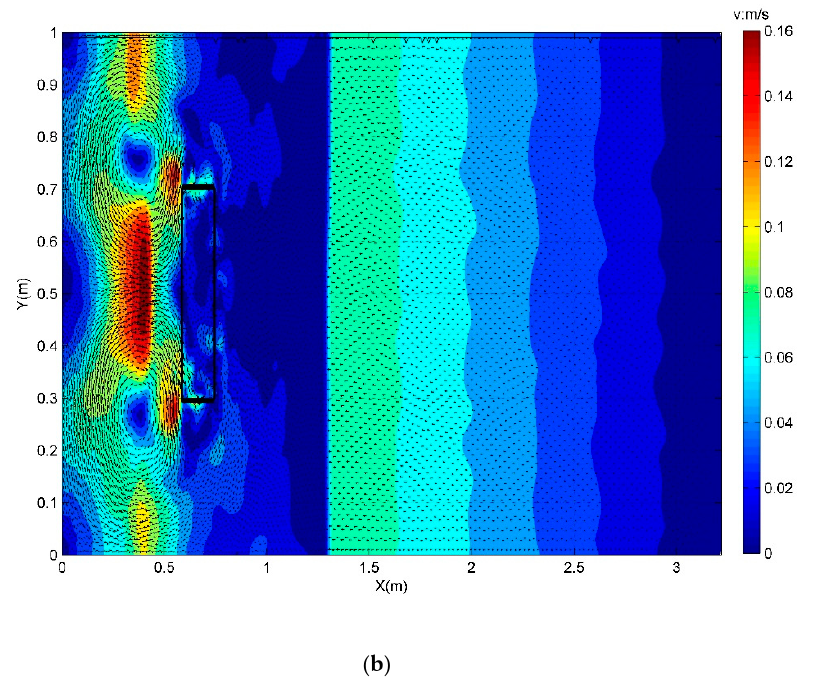
Figure 6. Velocity fields of dam break flow at different stages: ( a ) t = 0.74 s; and ( b ) t = 1.76 s.